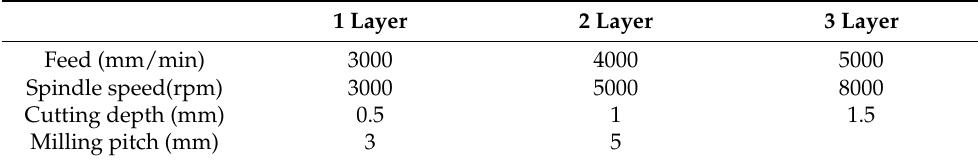
Table 3. Experimental parameter configuration.